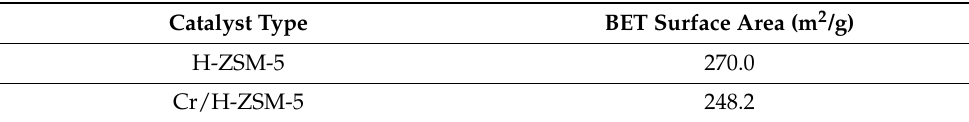
Table 1. BET surface area analysis of H-ZSM-5 and Cr/H-ZSM-5 catalysts.